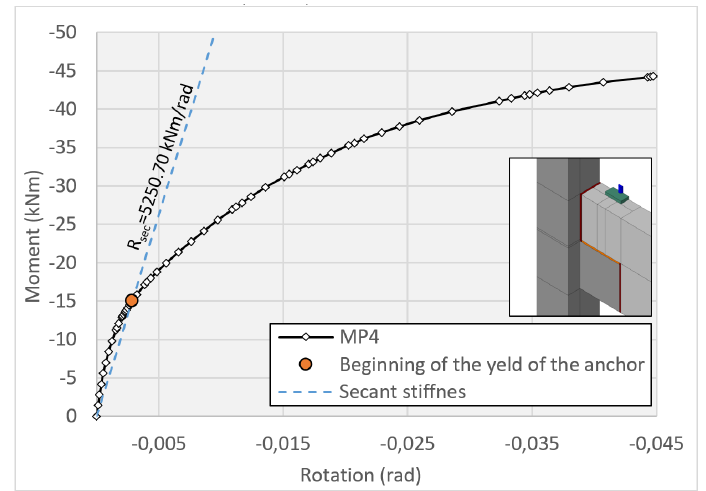
Figure 16. MP4 moment-rotation